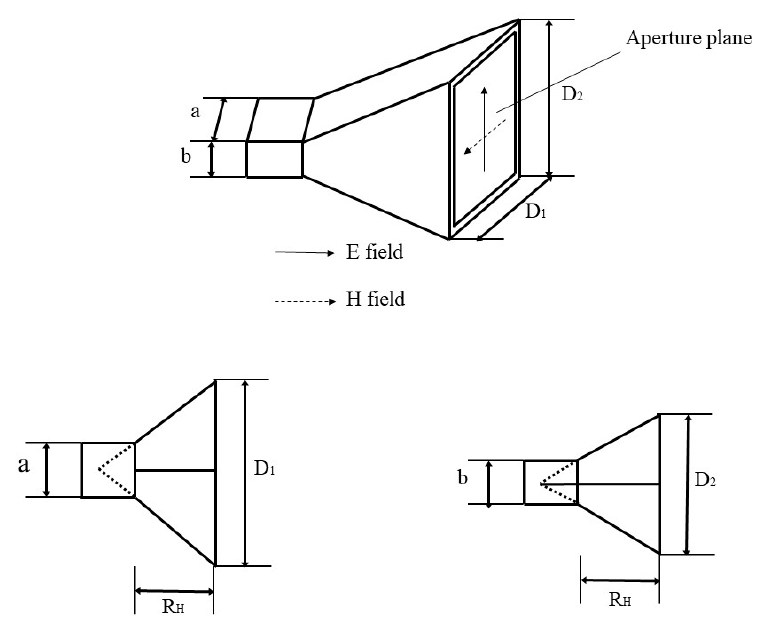
Figure 2. Structure of horn antenna [37].